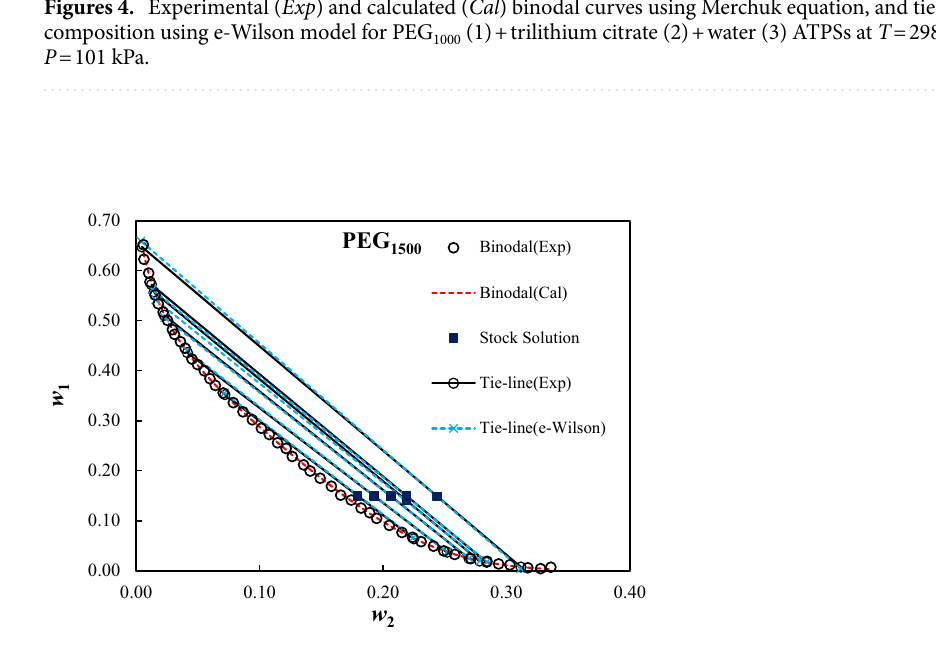
Figures 5. Like Fig. 5 for PEG 1500 (1) + trilithium citrate (2) + water (3) ATPSs.